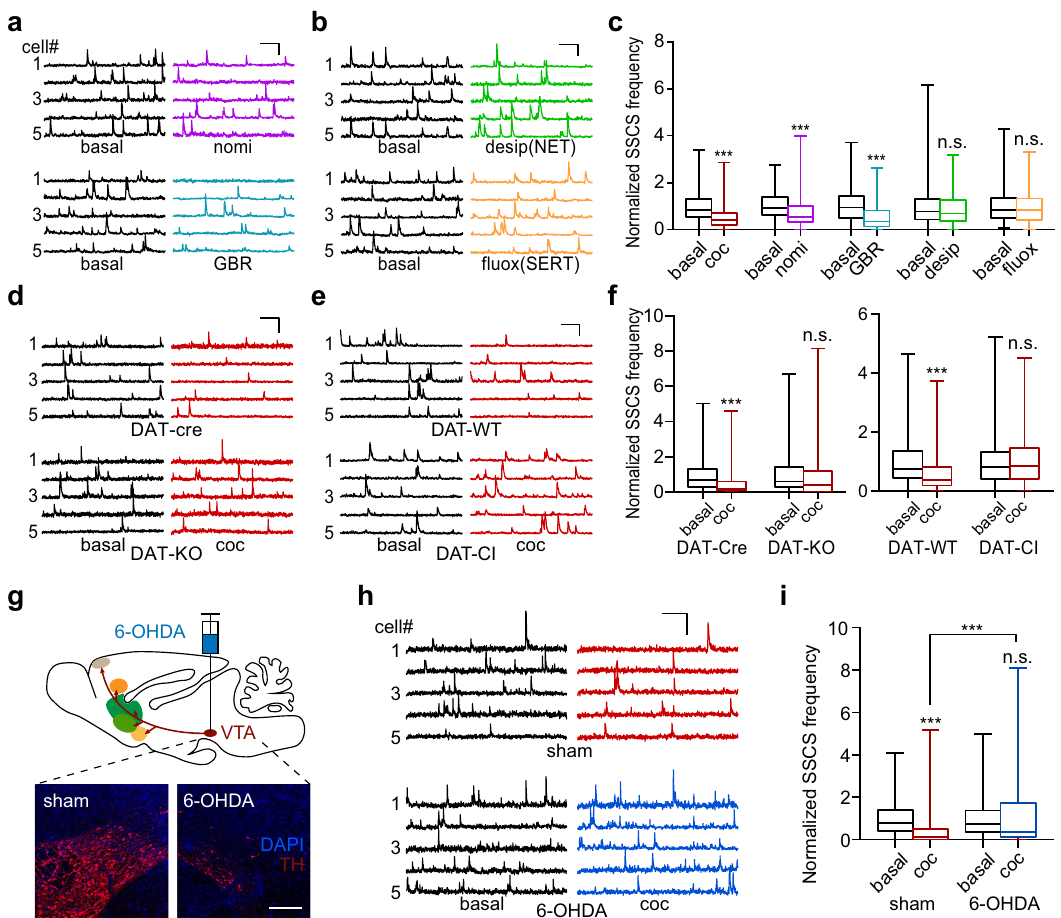
n =173neuronsfromfourmice;DAT-KO, n =202neuronsfrom fi vemice( p =0.12); DAT-WT, n =181 neurons from four mice; DAT-CI, n =282 neurons from fi ve mice ( p =0.28). g Con fi rmation by TH-immuno fl uorescence (red) that VTA dopamine neurons are lesioned by stereotaxic microinjection of 6-OHDA. Representative micrographs are from the same region of sham- and 6-OHDA-treated mice and alignedsymmetrically bythe midline, n =4,4 mice. Scale bar, 200 µ m. Cal-520 was used for imaging in the FrA. h , i Representative traces and normalized SSCS fre- quency (minimum, maximum, and three quartiles) in FrA neurons of sham- and 6- OHDA-treated mice before and after i.p. cocaine. Sham, n =151 neurons from four mice; 6-OHDA, n =171 neurons from four mice ( p =0.27). Two-tailed Wilcoxon test for ( c , f , and paired comparisons in i ) and two-tailed Mann – Whitney test for (unpaired comparisons in i ). *** p <0.001. Scale bars for traces, 20s, 200% dF/F 0 . Source data are provided as a Source Data fi